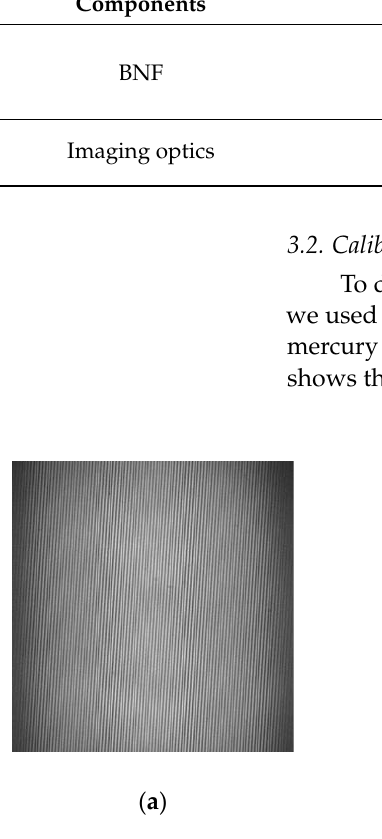
Figure 3. ( a ) Interferogram of the mercury lamp. ( b ) Spatial frequency profile obtained from the FFT. ( c ) After calibration, the position of the characteristic spectral line of the mercury lamp is 546.07 nm, 573.964 nm, and 579.067